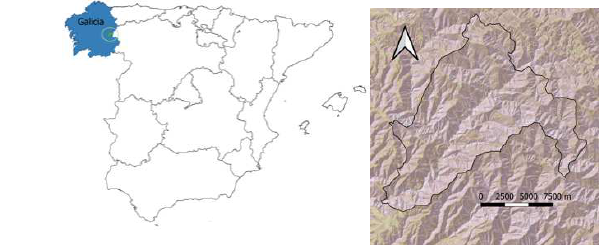
Figure 1. Study area. Background image hillshade and slope obtained from the Spanish Cartographical Institute (IGN, 2019).